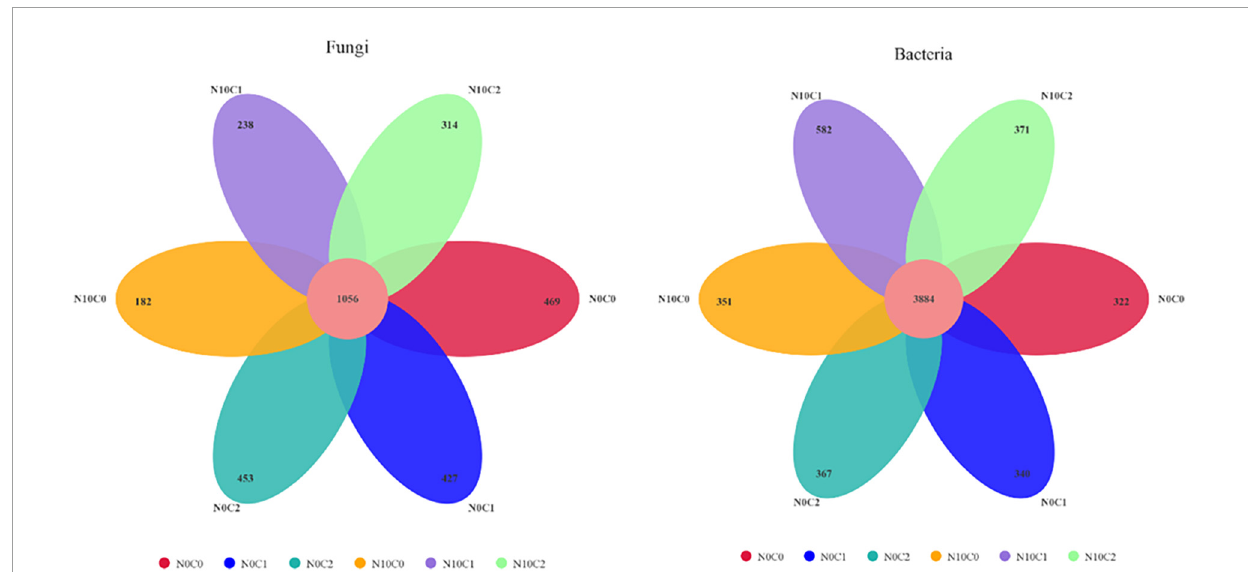
FIGURE4 Venn diagram of the soil fungal (left) and bacterial (right) OTU in N addition and litter manipulation treatments during 2014–2019. The numbers within circles represent the specific OTU in that treatment, the core number represents the common OTU present in all treatment.